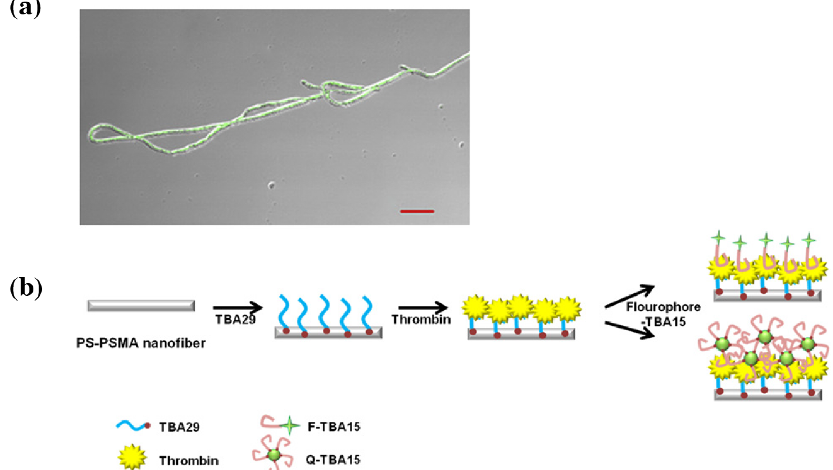
Figure 2. ( a ) Composite microscope picture combining the brightfield and fluorescence of anti-thrombin aptamer sandwich on nanofiber with a quantum dot-labeled secondary aptamer (scale bar: 20µm); ( b ) schematic of the nanowire-based anti-thrombin sandwich assay (TBA: thrombin-binding aptamer). Reprinted from [20], Copyright 2012, with permission from